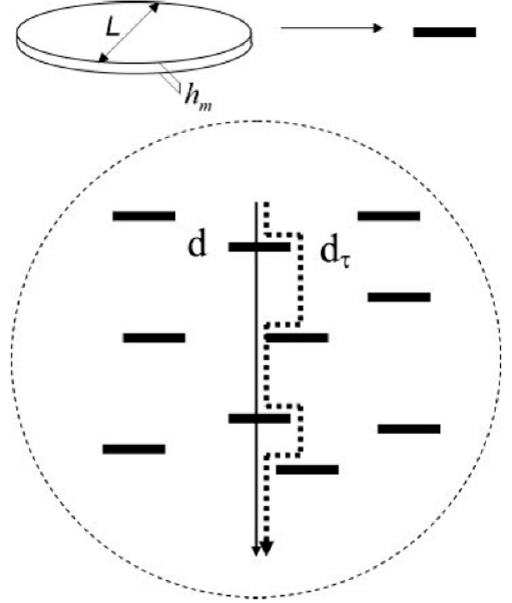
Figure 8. Sketch illustrating the Nielsen tortuosity diffusion model for the nanocomposite structure consisting of oriented layers (disks) homogeneously dispersed in the polymer matrix [113].